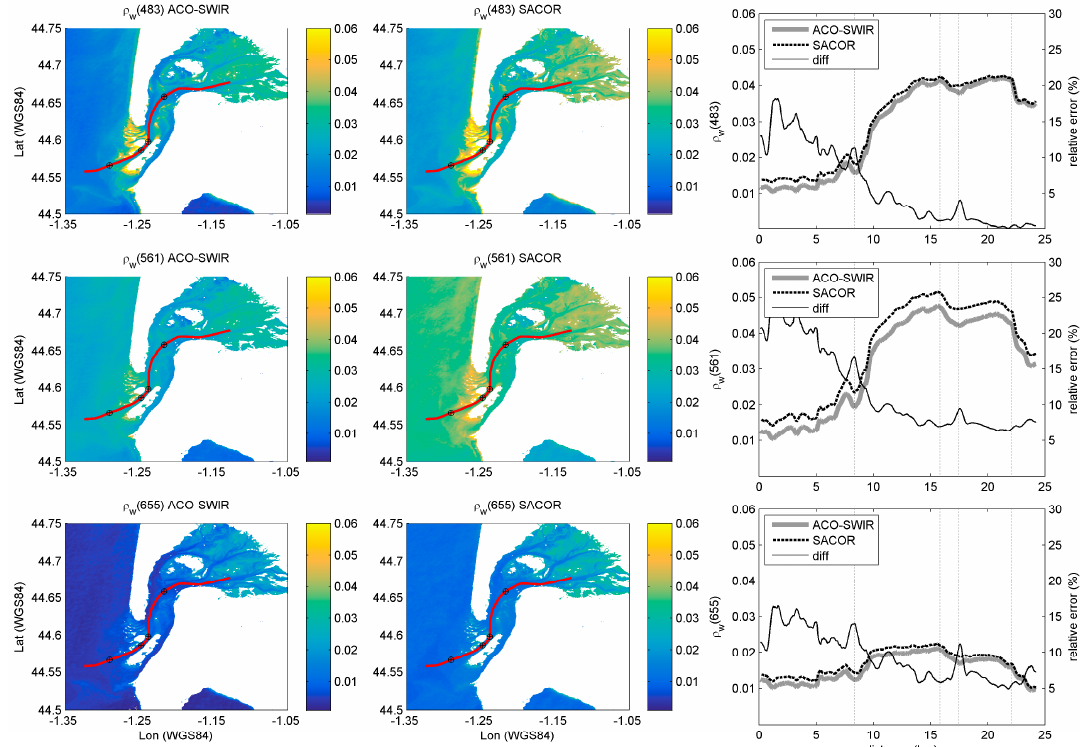
Figure 11. Comparison between the SACOR and SWIR-based ACOLITE (ACO-SWIR) atmospherically corrected ρ w at 483, 561 and 655 nm (from top to bottom) from the OLI scene acquired on 2015-10-20. The relative difference between the two products is computed along a 25-km cross-shore transection (red line) starting from the inner part of the lagoon to outer part of the inlet. Vertical dashed lines are associated with sea water optical changes, which are located on the images by black circles.